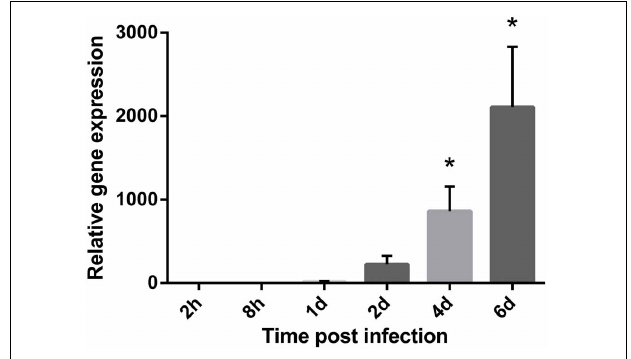
FIGURE 1 | Bacterial growth during a cold-water vibriosis infection. Relative expression levels of the 16S rRNA encoding gene (16S rDNA) in the blood of Atlantic salmon parr during an experimental V. salmonicida i.p.-infection. Each time point represents the average expression level of the bacterial reference genes in four fish and is reported as fold change averages ± standard error of the mean (s.e.m.) compared to the average expression levels of four control fish 2h after challenge. ∗ p < 0 .